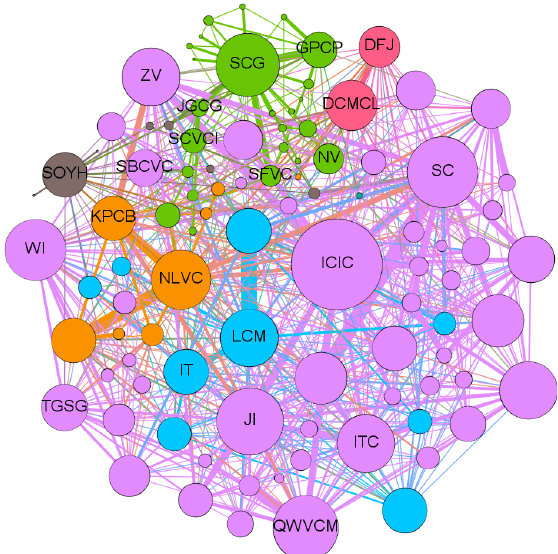
Fig. 4 Visual network diagram of community detection results of 42 VC industry leaders and 57 VC companies that have invested with them on four or more